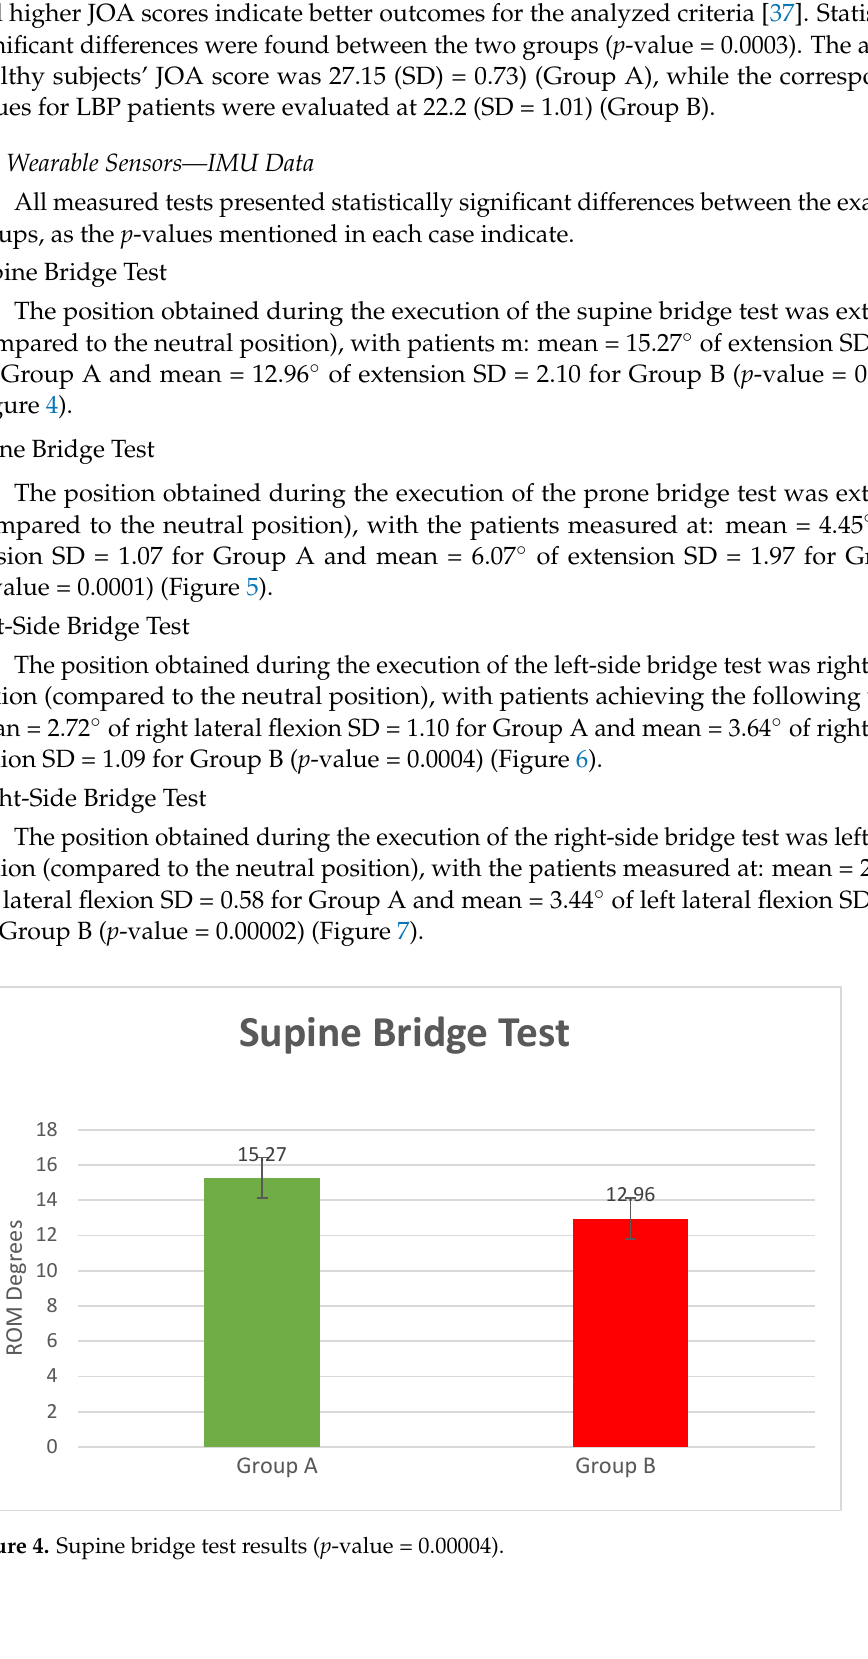
Figure 5. Prone bridge test results ( p -value = 0.0001) . Left-Side Bridge Test The position obtained during the execution of the left-side bridge test was right lateral flexion (compared to the neutral position), with patients achieving the following values: mean = 2.72° of right lateral flexion SD = 1.10 for Group A and mean = 3.64° of right lateral flexion SD = 1.09 for Group B ( p -value = 0.0004) (Figure 6).